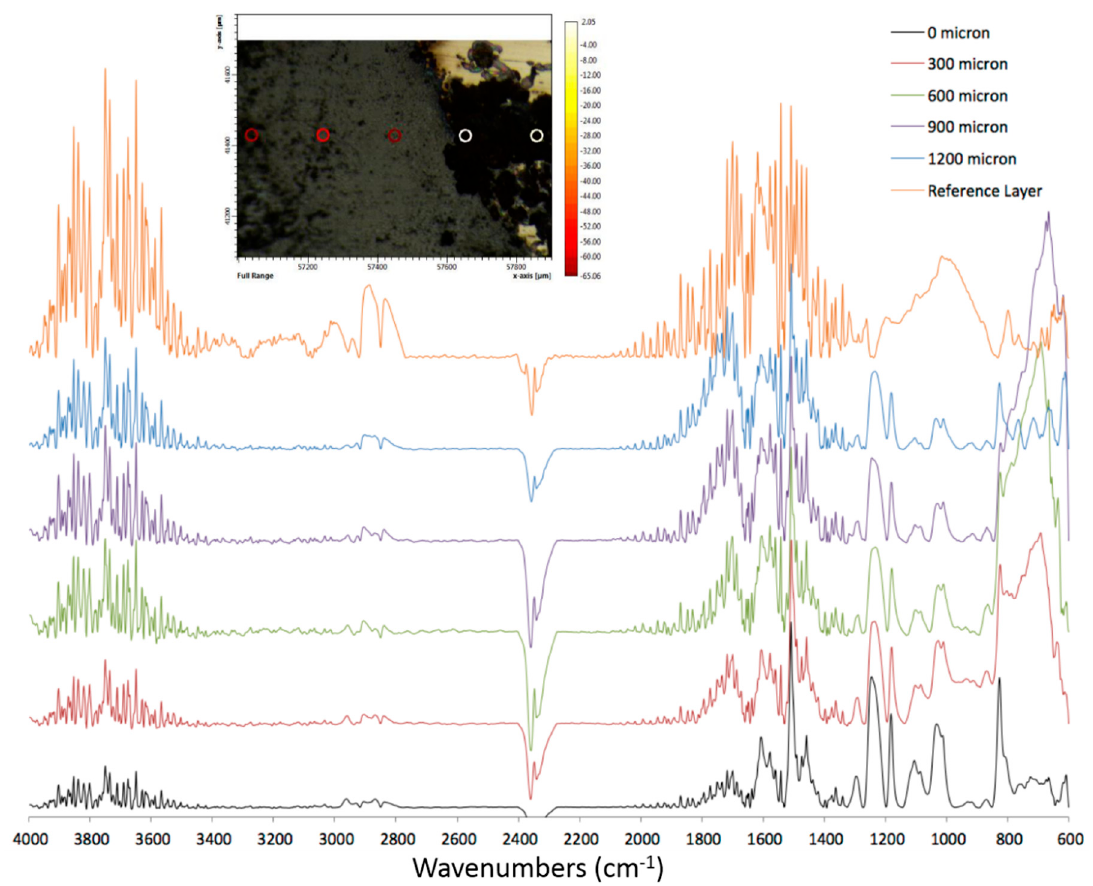
Figure 12. FTIR spectra with different locations (colored dots in the image) measured at the interface between the joining bit and CFRP.